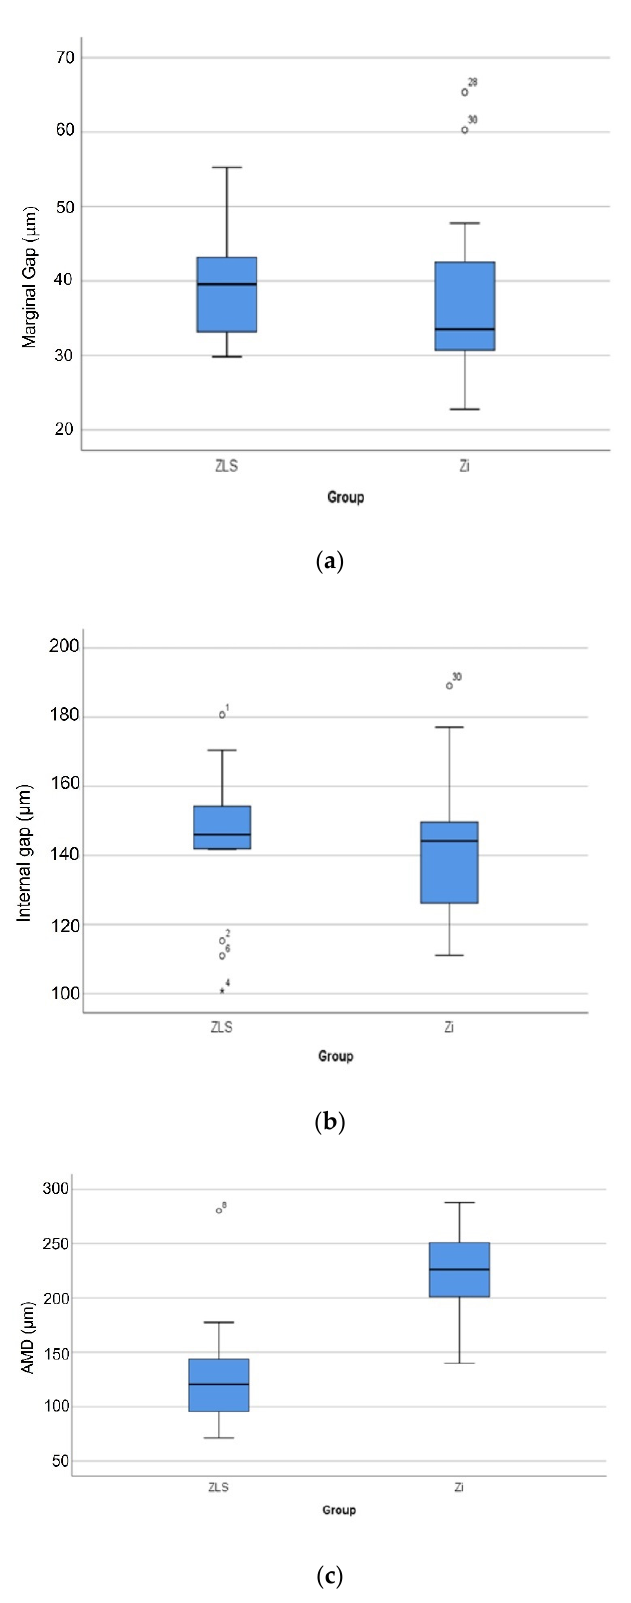
Figure 7. Box plot graphs showing the distribution of marginal gap ( a ), internal gap ( b ), and AMD ( c ) values. Circles and stars denote outliers with the test sample numbers displayed.